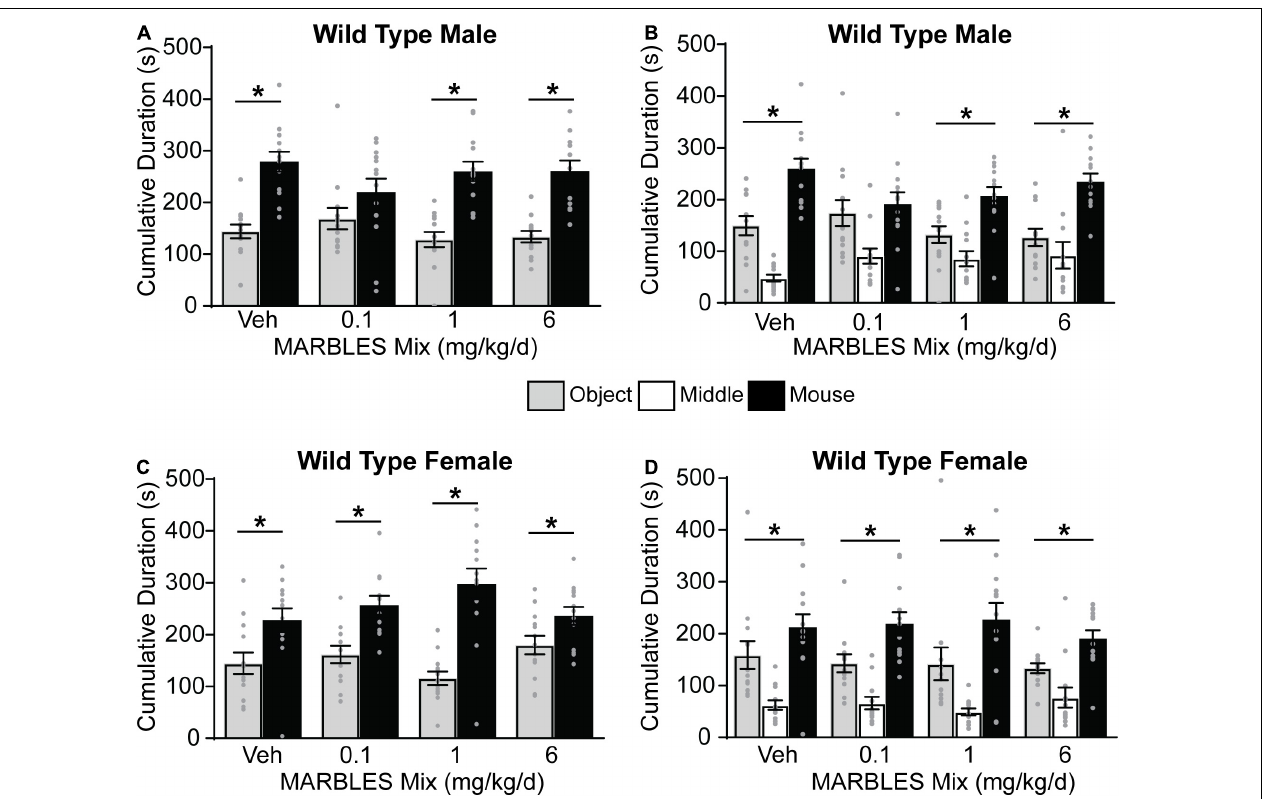
FIGURE 3 | Developmental exposure to 0.1 mg/kg of MARBLES PCB mix in the maternal diet decreased sociability in male WT mice. (A,C) The amount of time males (A) or females (C) spent sniffing either a novel sex- and age-matched mouse vs. a novel object. (B,D) The amount of time males (B) or females (D) spent on each chamber side. Data presented as mean ± SEM ( n = 12–13). * Indicates significant difference between novel mouse vs. novel object at p < 0.05 as determined using an unpaired t -test or Mann-Whitney